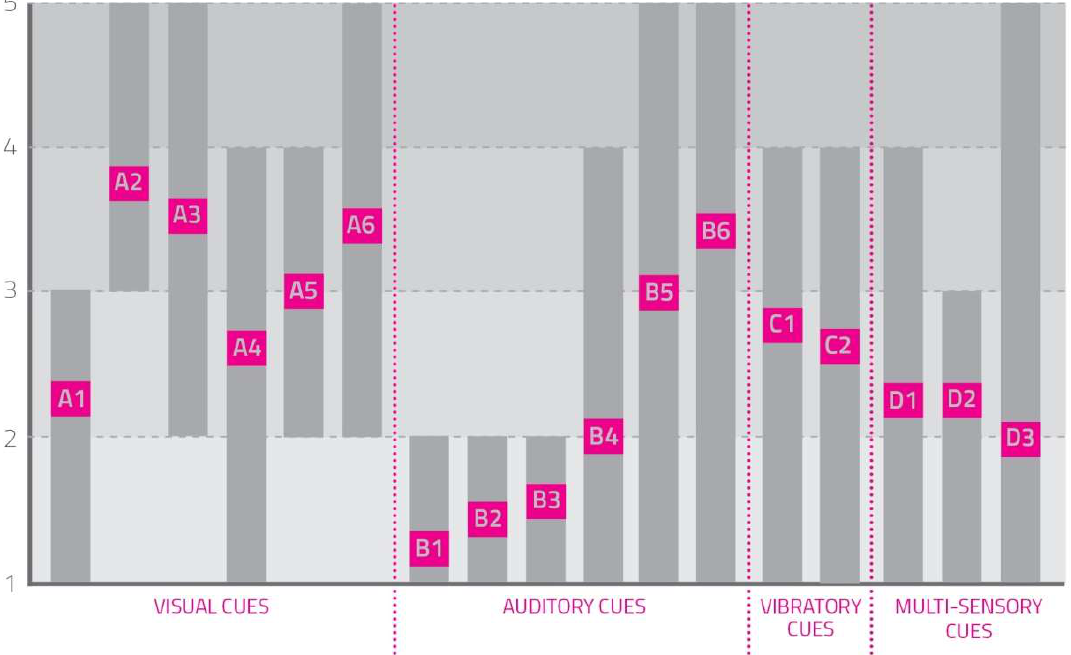
Figure 3. How difficult it was to follow the rhythm suggested by each cue? The rectangles in the figure represent the answers given by users, their median values (the pink squares containing the name of the single cue), and distribution and variability (the length and placement of the gray rectangle).